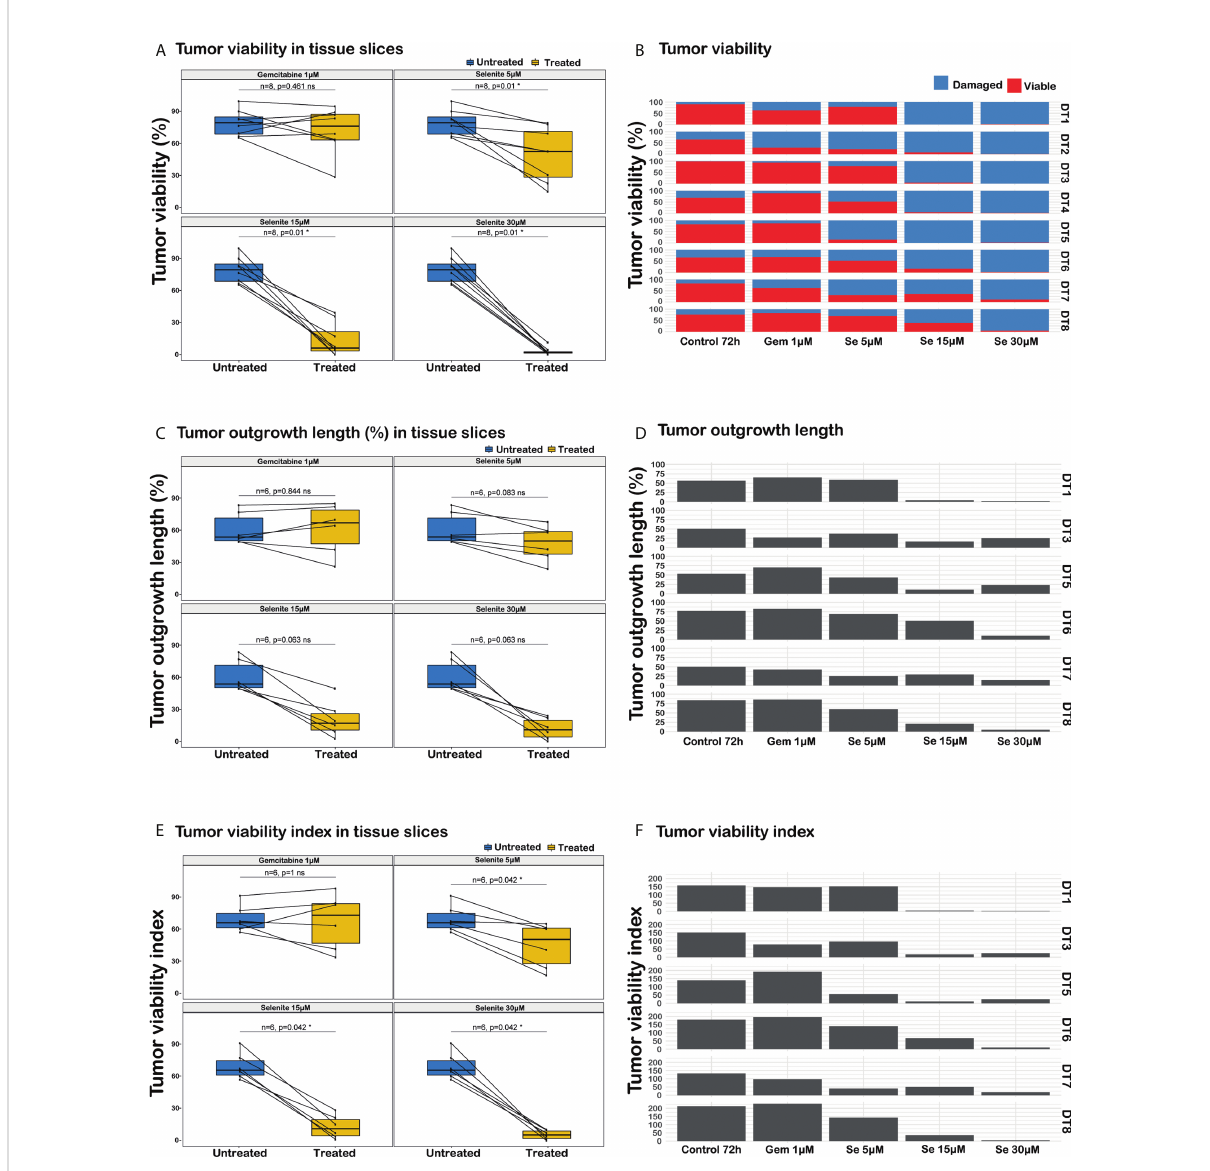
FIGURE 4 Analysis of responses to sodium selenite treatments in ex vivo cultured tissue slices of human PDAC. (A) PDAC cell viability, (B) Quantitation of PDAC cell viability in the different treatment conditions, (C) Cancerous outgrowth length, (D) Quantitation of cancerous outgrowth length in the different treatment conditions, (E) Tumor viability index (TVI), (F) Quantitation of tumor viability index in the different treatment conditions, TVI is de fi ned as S i=viable, damaged (% outgrowth length i * weight i ), where weight viable =3 and weight damaged =1. Statistical signi fi cance according to paired Wilcoxon signed-rank test with Benjamini-Hochberg correction for multiple testing and a -value